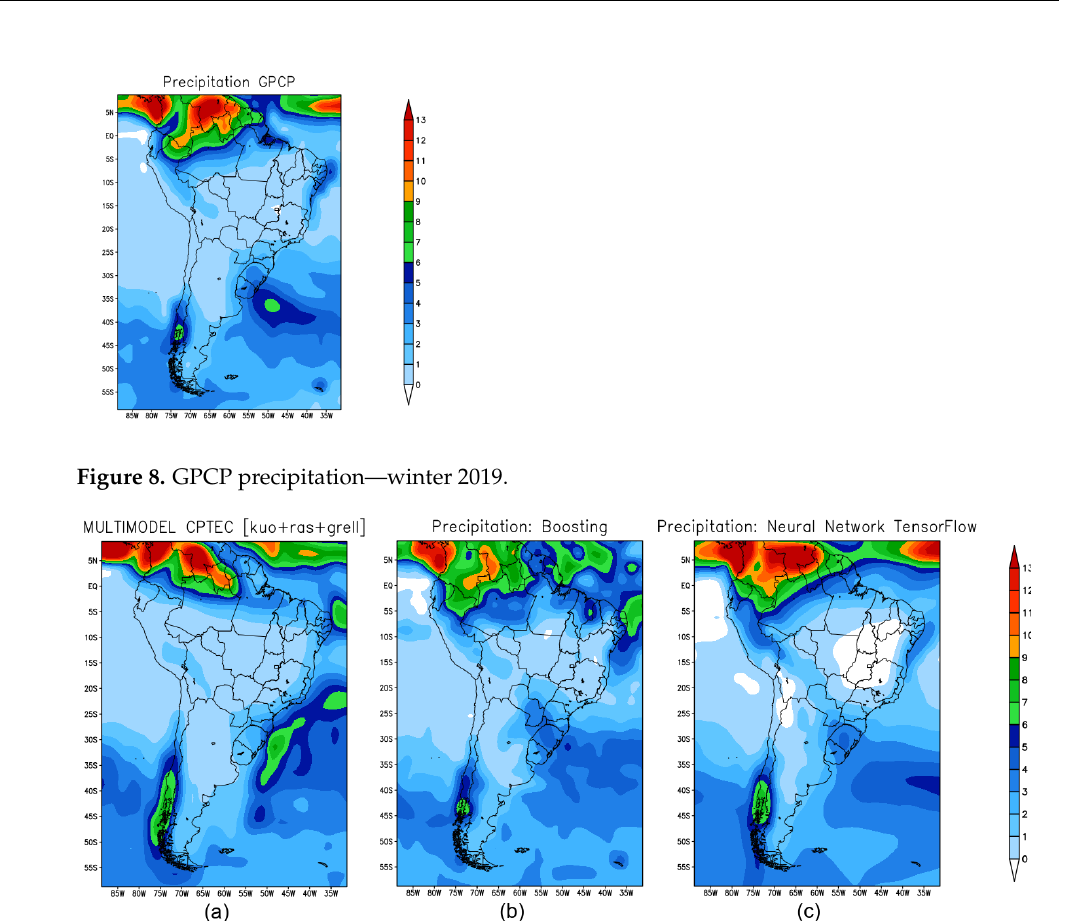
Figure 9. Seasonal climate prediction for winter in South America: ( a ) precipitation predicted by BAM; ( b ) prediction obtained by XGB; ( c ) precipitation prediction obtained using TF.